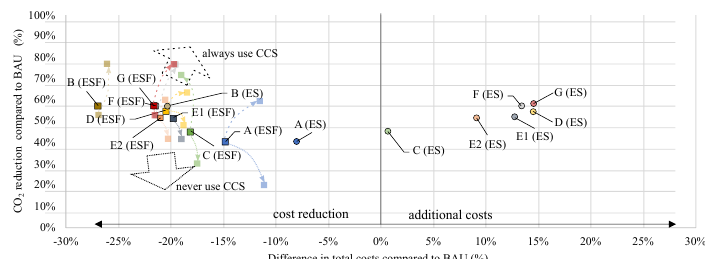
Figure 14. CO 2 mitigation and impact of CCS with respect to cost difference to BAU scenario.